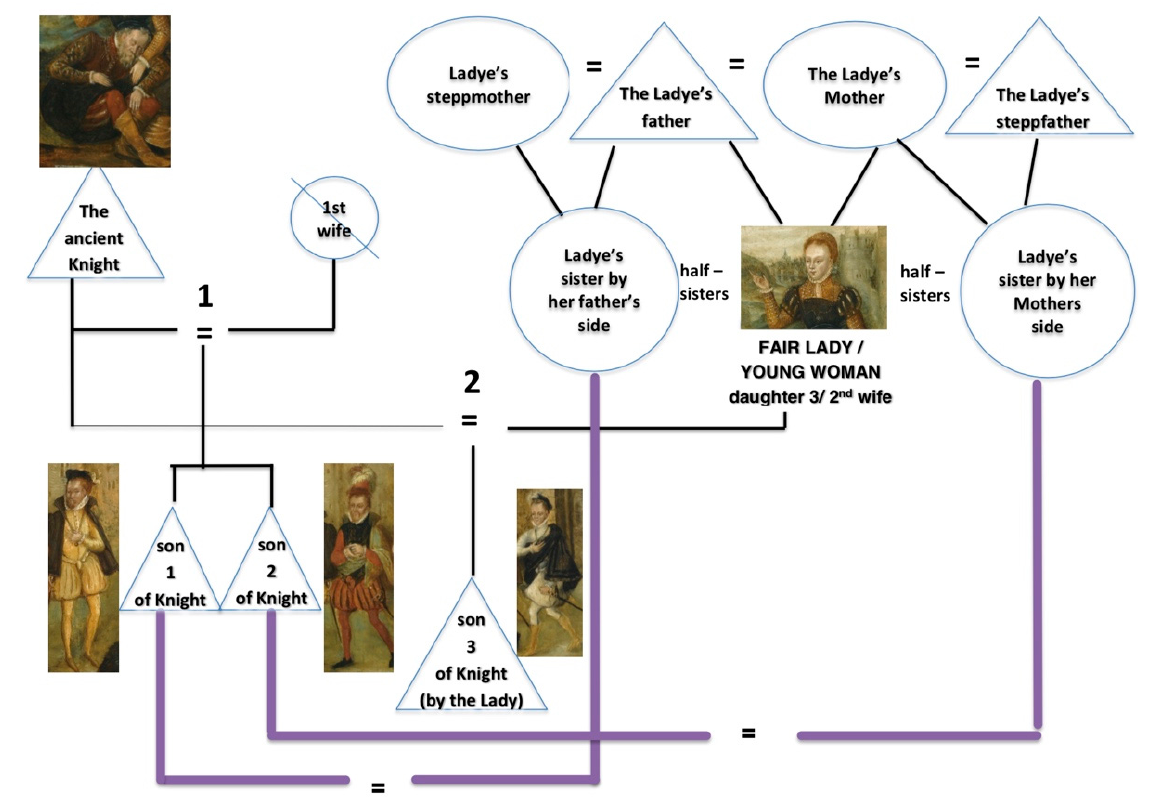
Figure 14. Modernized diagram of ‘The L[or]d Treasurer Burleigh’s riddle for Consanguinity’, shown with figures from the riddle painting ‘devoted’ to Sir William Cecil, Hatfield House, Hertfordshire, UK, courtesy of the Marquess of Salisbury. Drawing credit: Lyndan Warner.